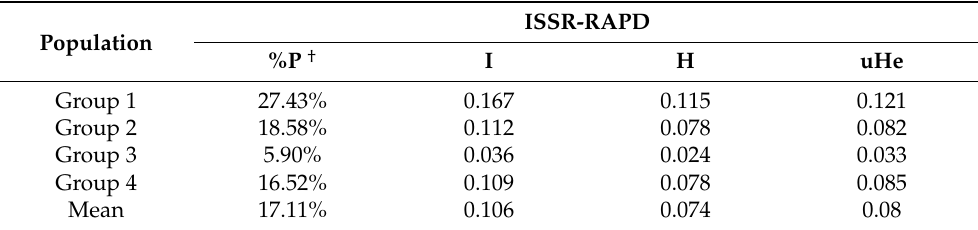
Table 5. The Genetic diversity values by combining RAPD and ISSR markers in Meloidogyne javanica populations were collected from Iran (groups defined based on K =